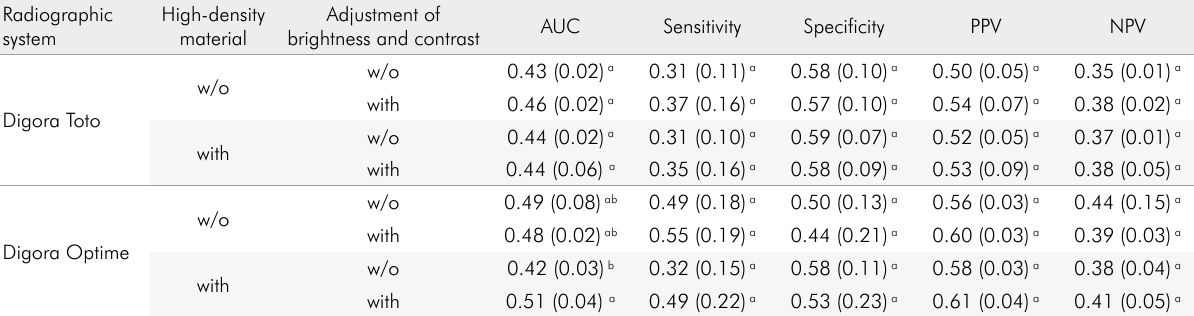
Table 2. Mean values (standard deviation) of the area under the ROC curve (AUC), sensitivity, specificity, positive predictive value (PPV) and negative predictive value (NPV), in the radiographic diagnosis of proximal caries using two digital systems, with and without (w/o) a high-density material and adjustment of brightness and